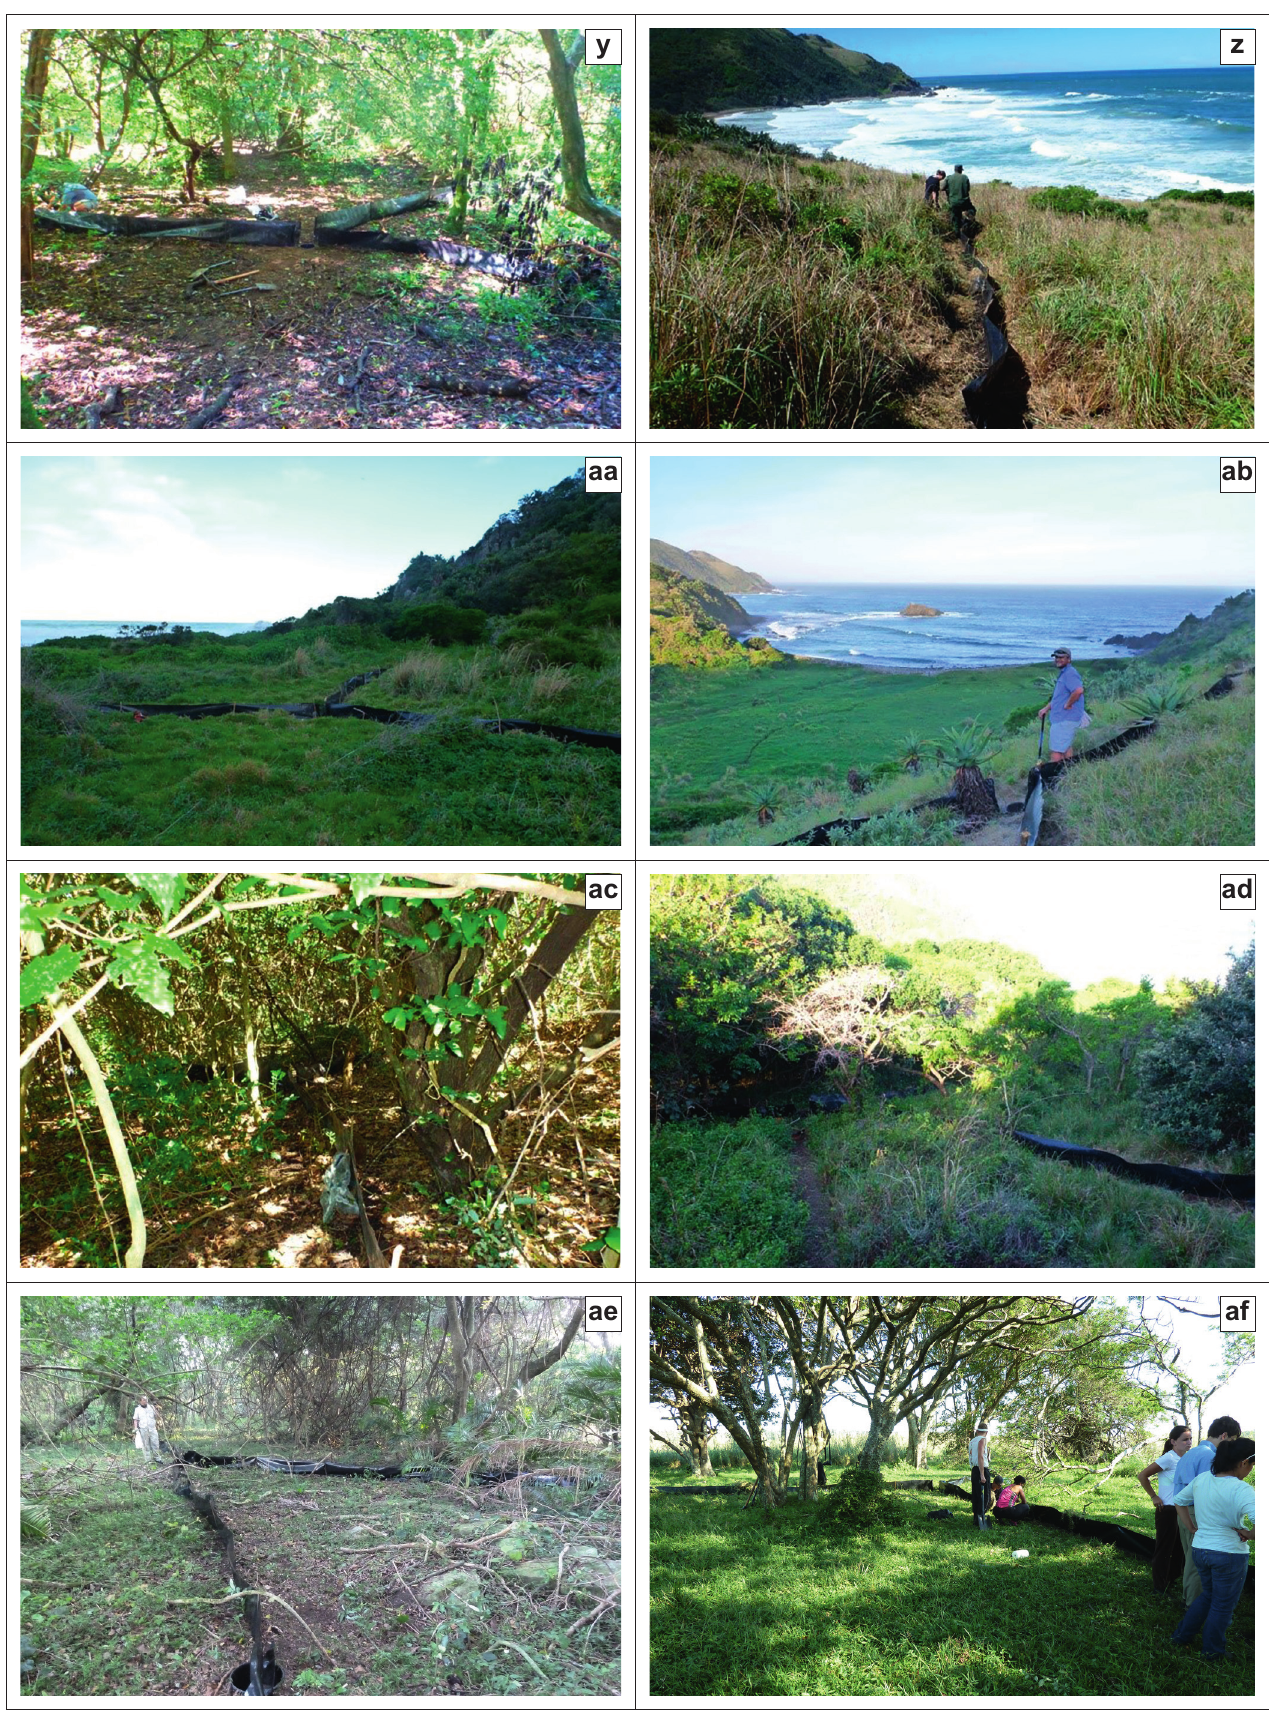
FIGURE 1-A4 (Continues...): (a–ai) Habitat type and trap layout of the respective trap sites surveyed during this study.